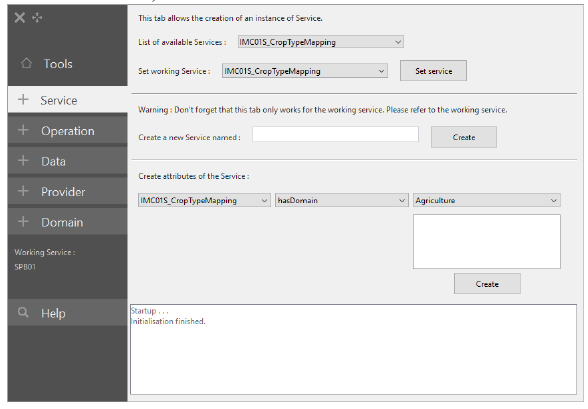
Figure 2. Graphical User Interface